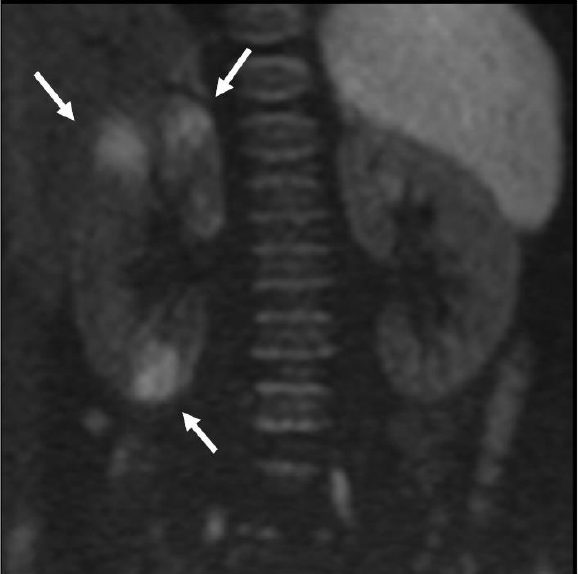
Figure 2. Patient with fUTI: signs of acute parenchymal involvement (multiple focal renal lesions) detected by DWI ( b -value diffusion = 1000).